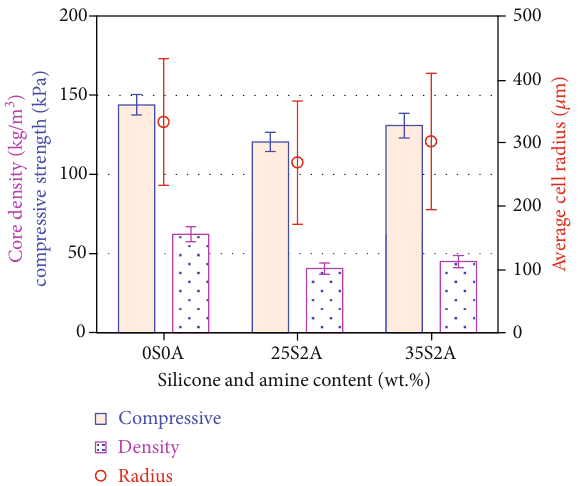
Figure 5: Dependence of the pore size distribution on the surfactants.